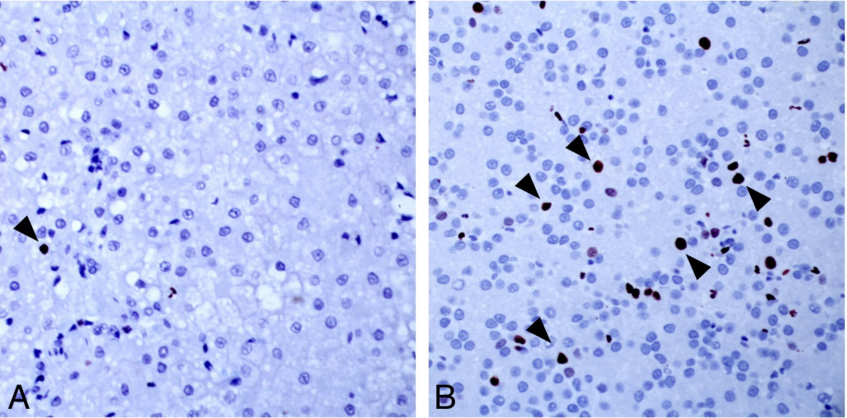
Figure 3. Ki67 immunohistochemistry of a DCH-negative region of HCC ( A ), and a DCH-positive region of HCC ( B ). Virus positive regions were defined by ISH. Arrowheads in both ( A ) and ( B ) denote hepatocyte nuclei expressing Ki67. Cell cycling is higher in regions of the tumor that are positive for